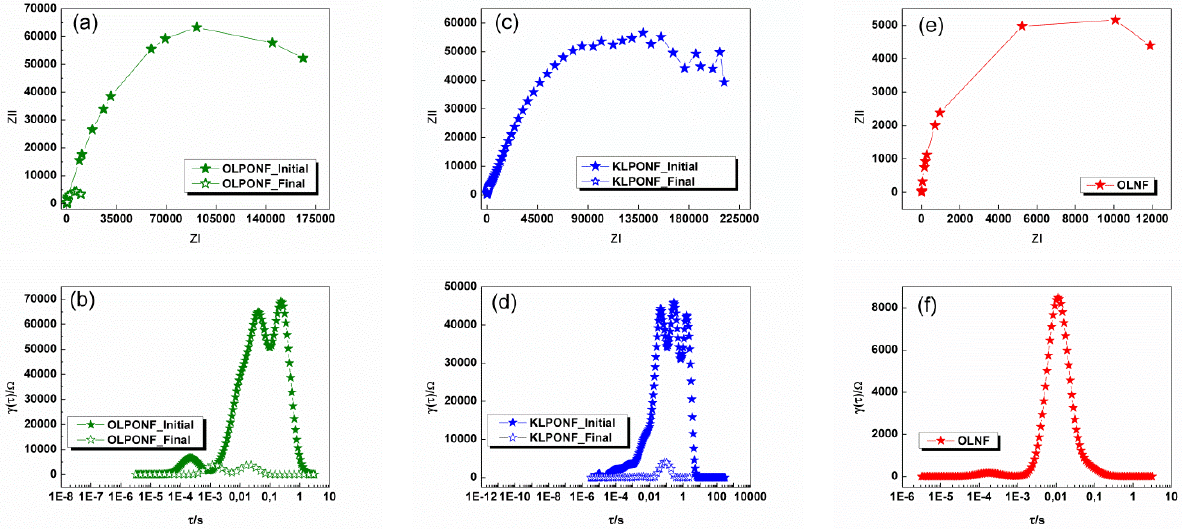
Figure 10. Nyquist and distribution of the relaxation times (DRT) plots corresponding to the impedance spectra of the; ( a , b ) OLPONF, ( c , d ) KLPONF, and ( e , f ) OLNF electrodes before and after the GCPL cycling measurements, respectively.